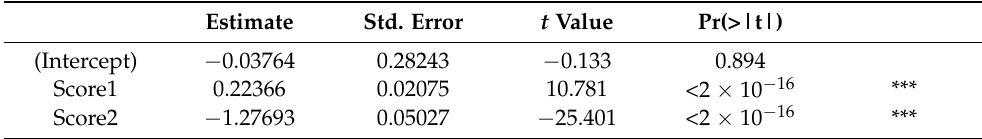
Table 3. Regression Results for the Pooled Data. Estimate Std. Error t Value Pr(>|t|) (Intercept) − 0.03764